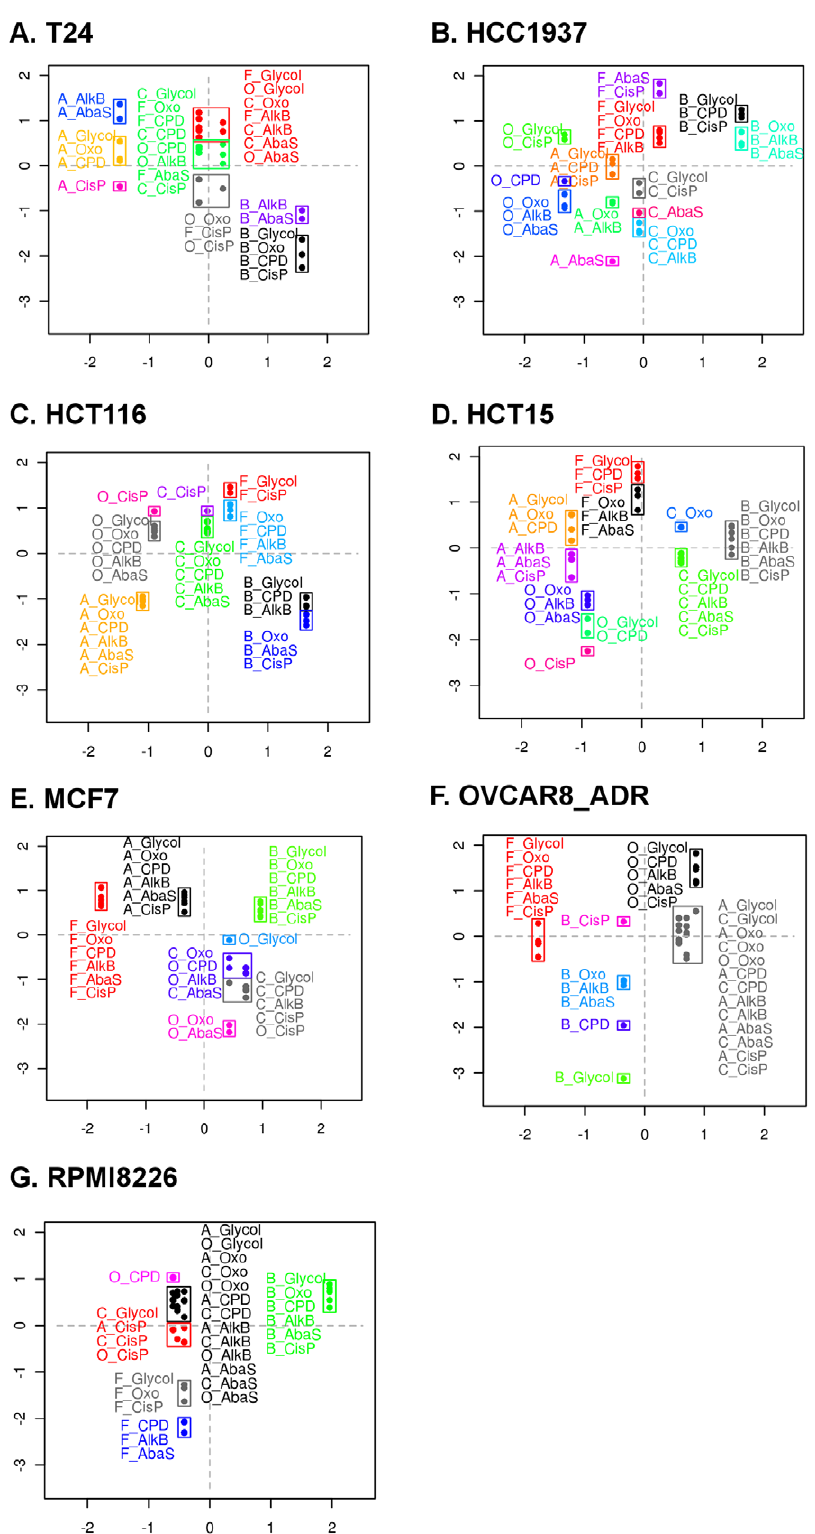
Figure 4. Visualisation of the association between the DNA repair response (sub-pathways) and chemosensitivity. We reported, for each cell line, the means of log2(T/NT) data (Y-axis) gathered for each treatment of the 2 sets of experiments as a function of the corresponding log10(IC20) (X-axis). Data were standardized within each cell line series (mean=0 and standard deviation=1). Within each chart, the lesion-treatment associations belonging to the same cluster were framed together. The corresponding cluster dendrograms are displayed in Supplementary Fig. S2 (the letters ahead of the lesions refers to the treatment: A=adriamycin; B=BCNU; C=cisplatin; F=5-FU; O=oxaliplatin).